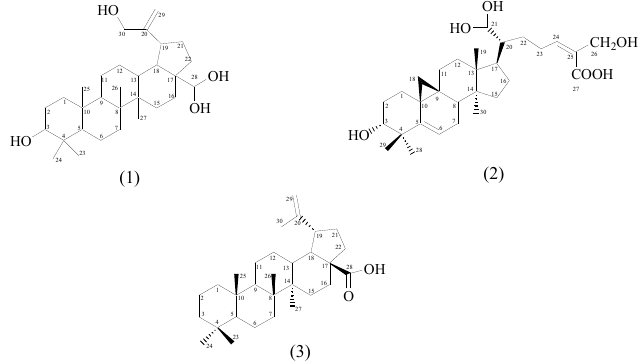
Figure 1. New terpenoids from F. aurantica .